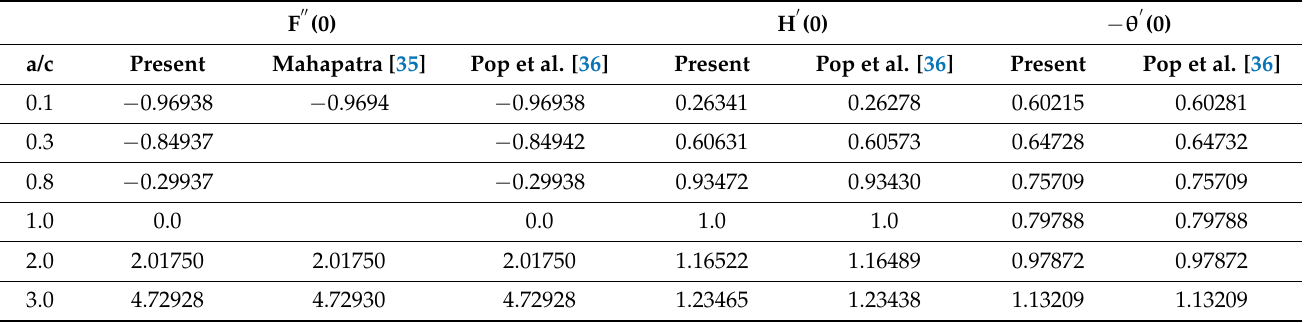
Figure 11. Streamlines for φ = 0 and φ = 0.1 with γ = − 1. Table 2. Comparison table for stretching ratio B = a / c when φ = n = K = 0.